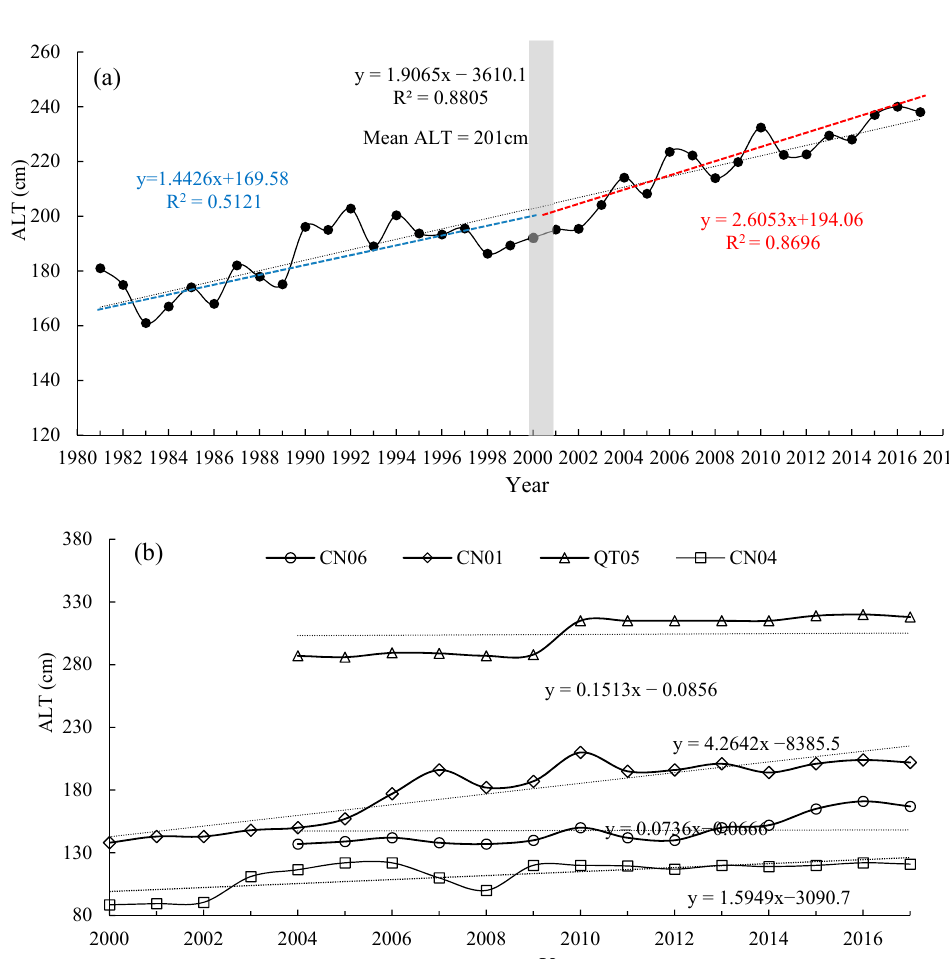
. Figure 7. The annual change in averaged active layer thickness (ALT) during 1981–2017 ( a ) and the